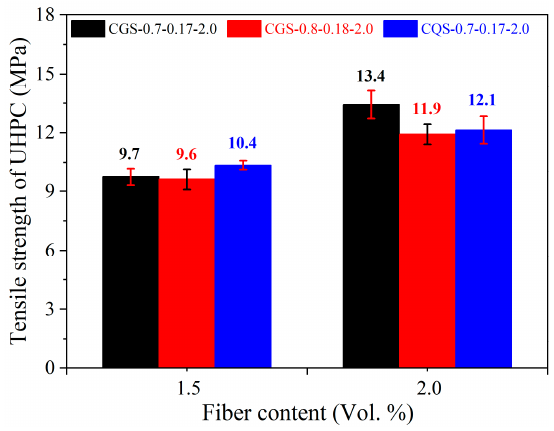
Figure 8. The tensile strength of the UHPC.